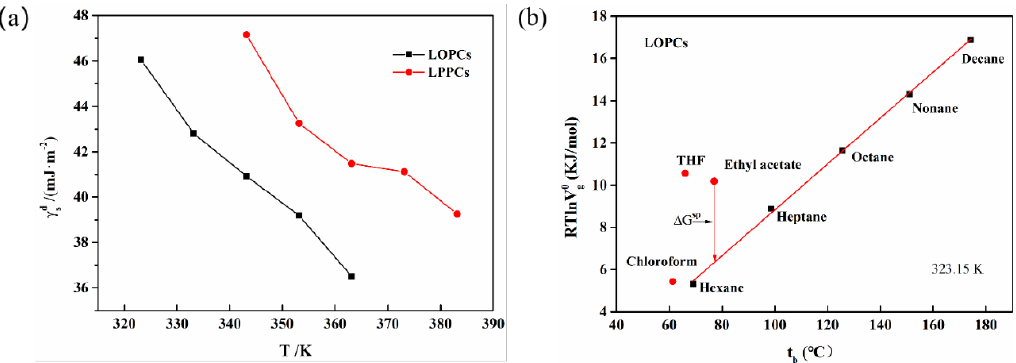
Figure 7. ( a ) Dispersion components of LPPCs and LOPCs at different temperatures; ( b ) Sawyer method: Relationship with probe solvent boiling point t b (at 323.15 K, for LOPCs).